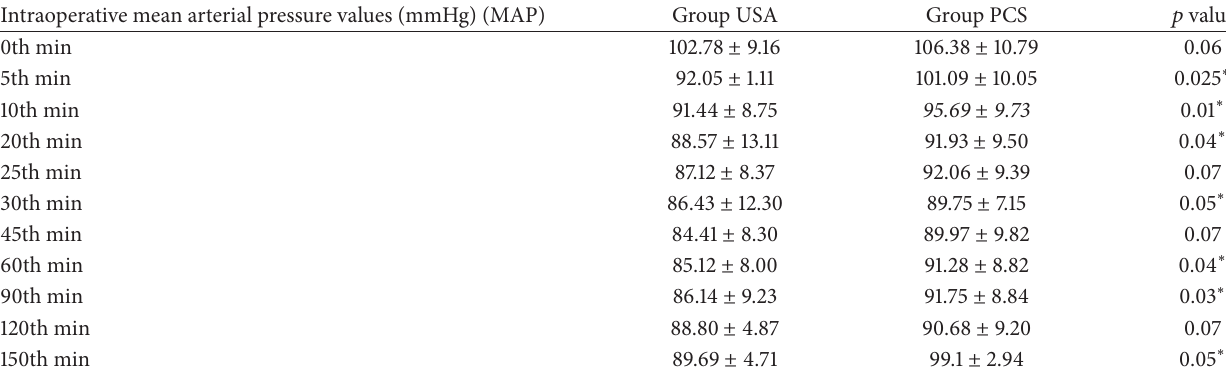
Table 2: Intraoperative mean arterial pressure changes (mmHg) (mean ± SD). In between-groups comparisons; ∗ 𝑝 < 0.05 . Intraoperative mean arterial pressure values (mmHg)